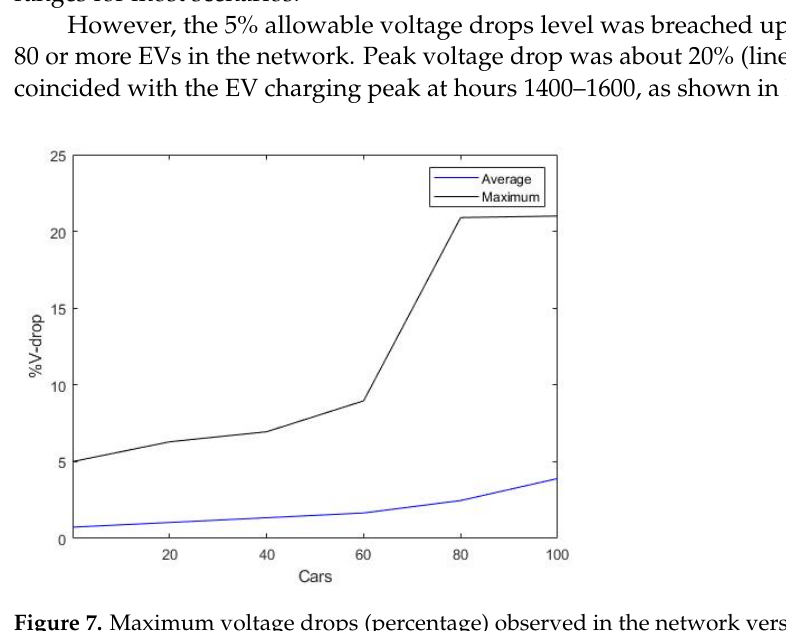
Figure 7. Maximum voltage drops (percentage) observed in the network versus average observed for all terminals when plotted against the EV penetration.